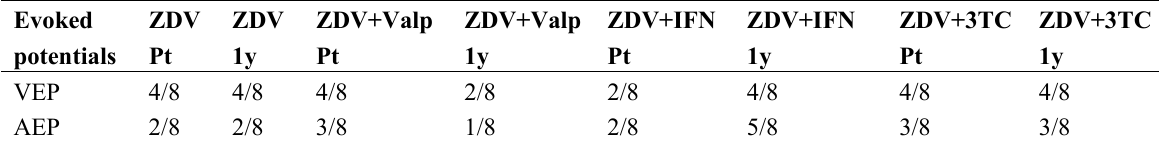
Table 2. Proportion of cats with abnormal evoked potentials in each group prior to commencement of treatment (Pt) and one year post-treatment (1y).